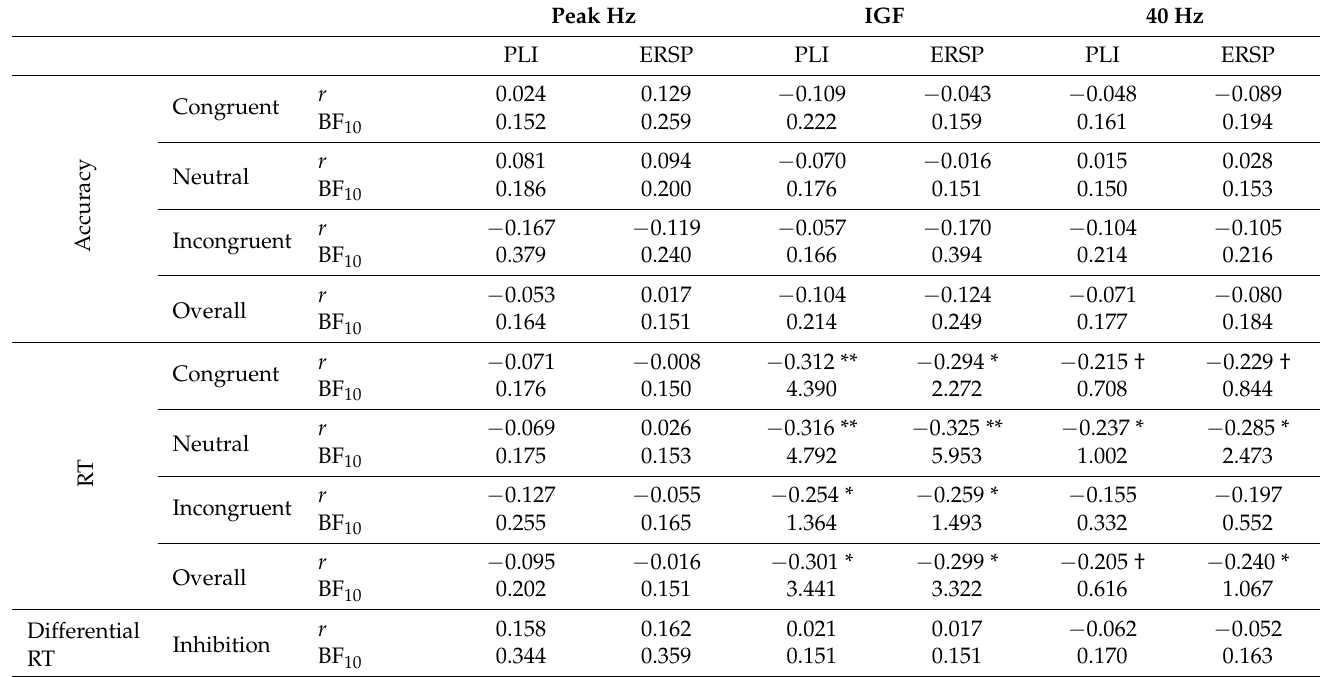
Table 3. The relationship between cognitive and ERF